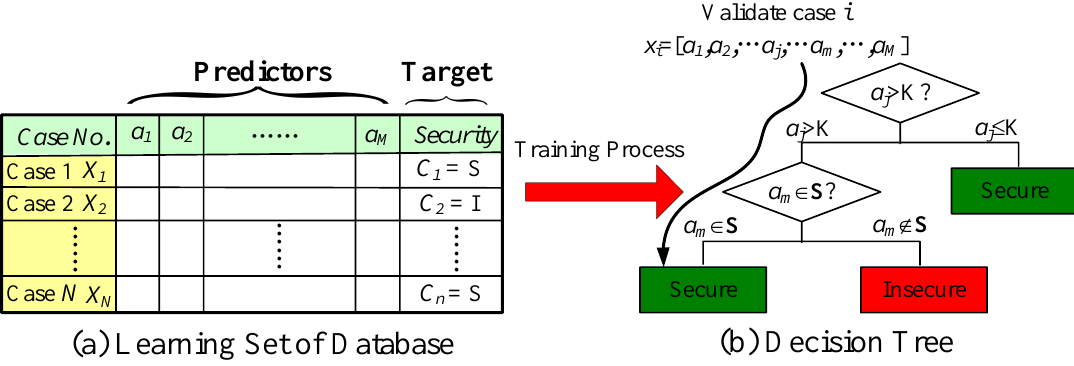
Figure 1. Illustration of a training database and a single decision tree (DT).